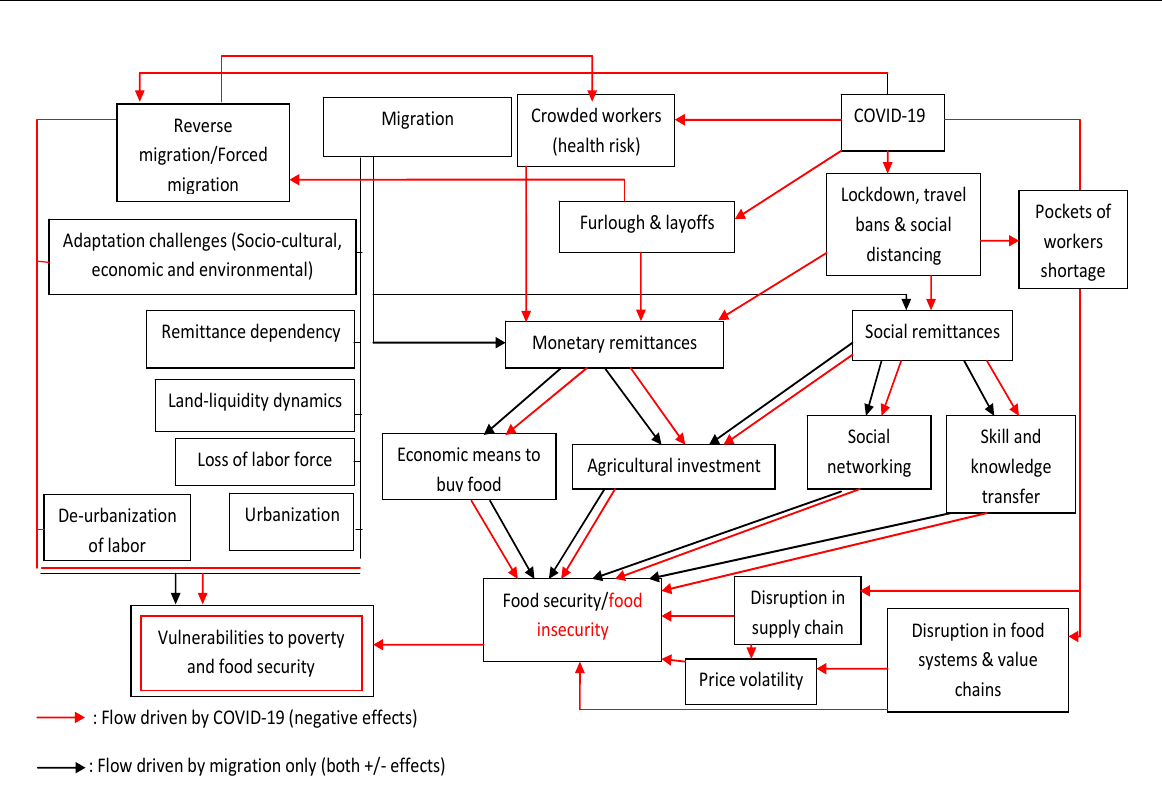
Figure 1. Nexus of Migration, Food Security, and